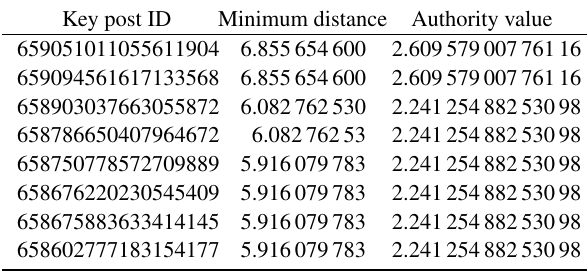
Table 2 Minimum distance and authority of posts.